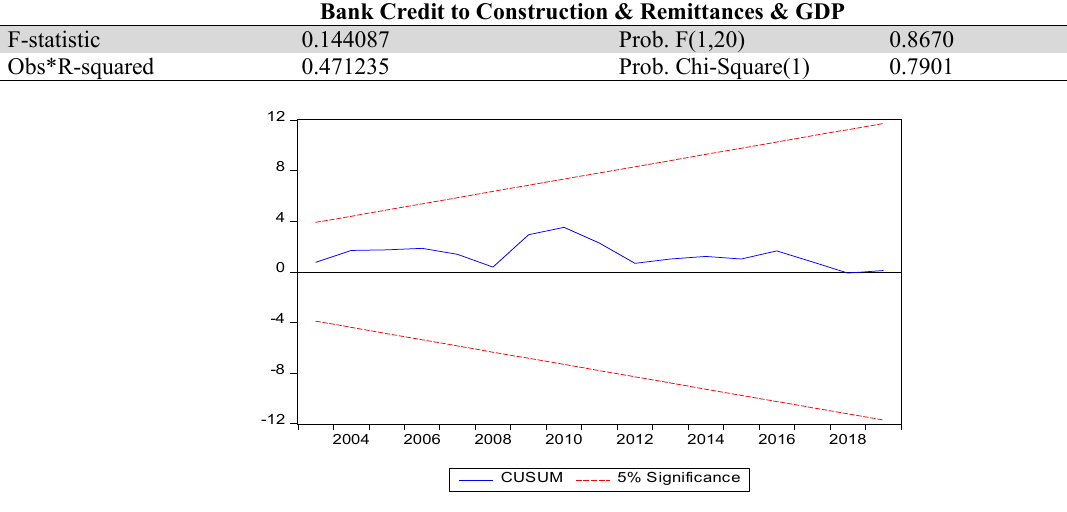
Fig. 5. CUSUM Test: Bank Credit to Construction & Remittances & GDP